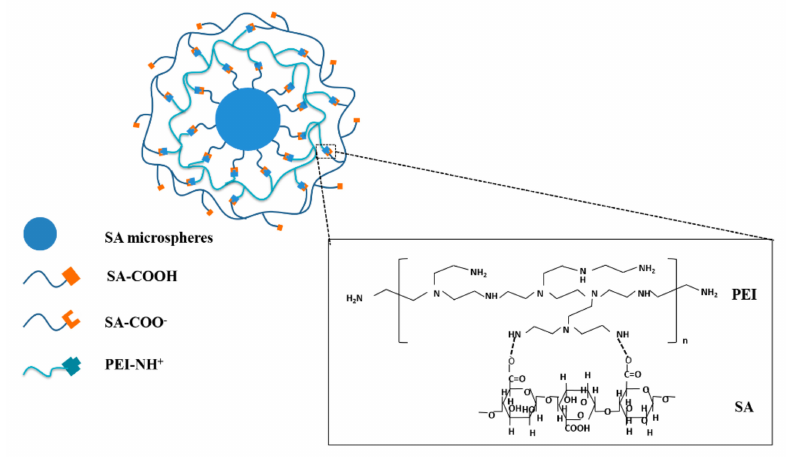
Figure 1. Preparation of SA / PEI / SA (SPS) spheres. SA: sodium alginate; PEI: